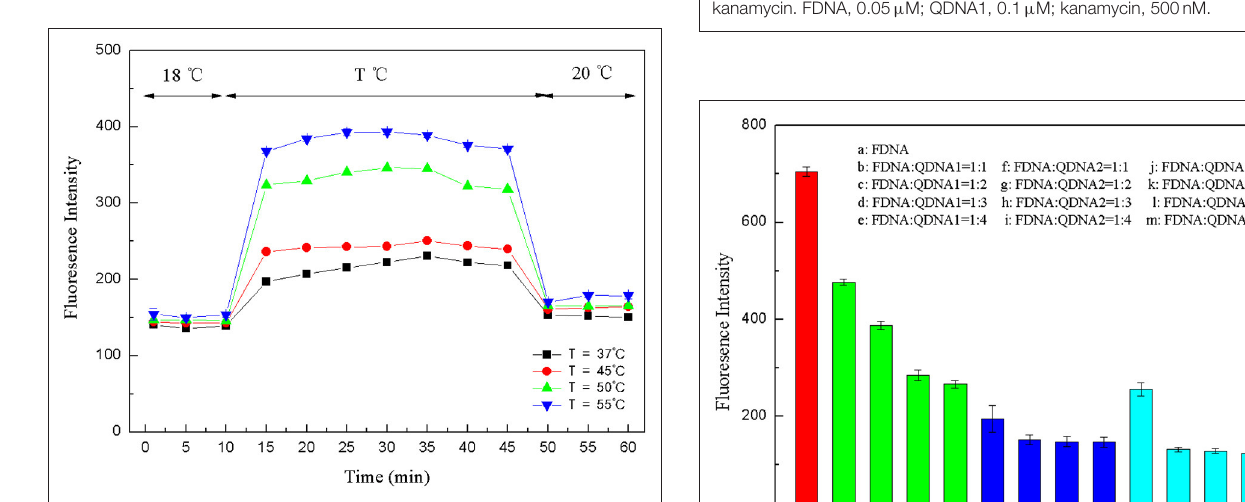
FIGURE 2 | Fluorescence intensity changes of structure-switching aptamers at different temperatures. FDNA, 0.05 µ M; QDNA, 0.1 µ M.